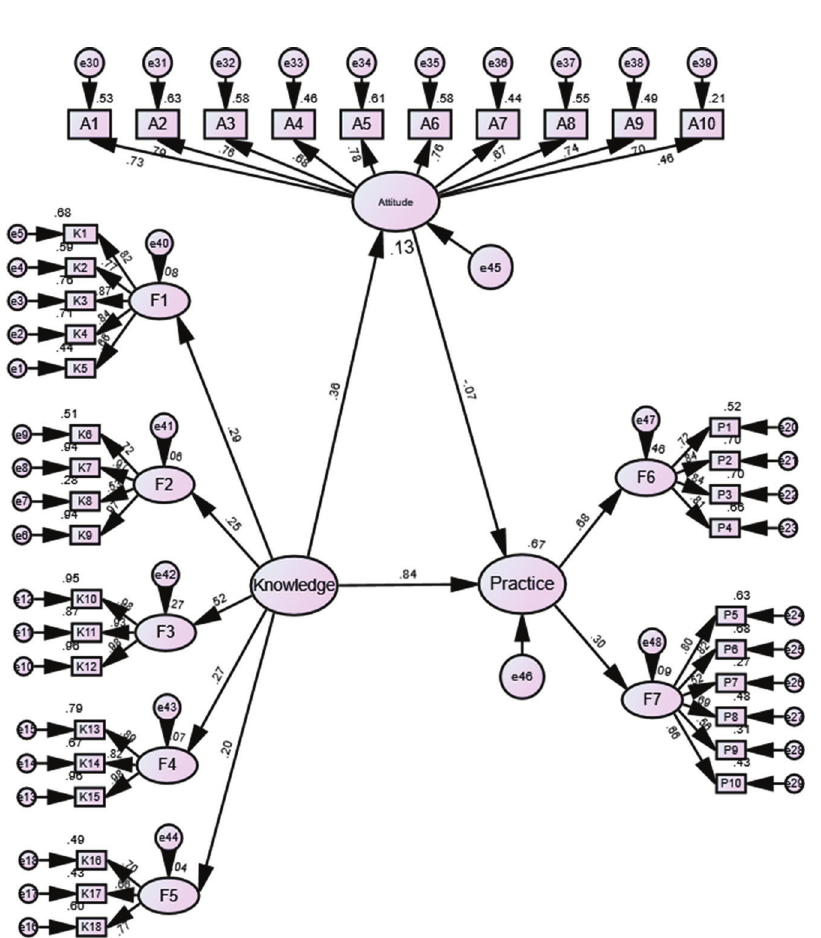
Figure 2. Path diagram of nursing staff’s knowledge, attitude, and practice on nosocomial infections ( N2 = 340).